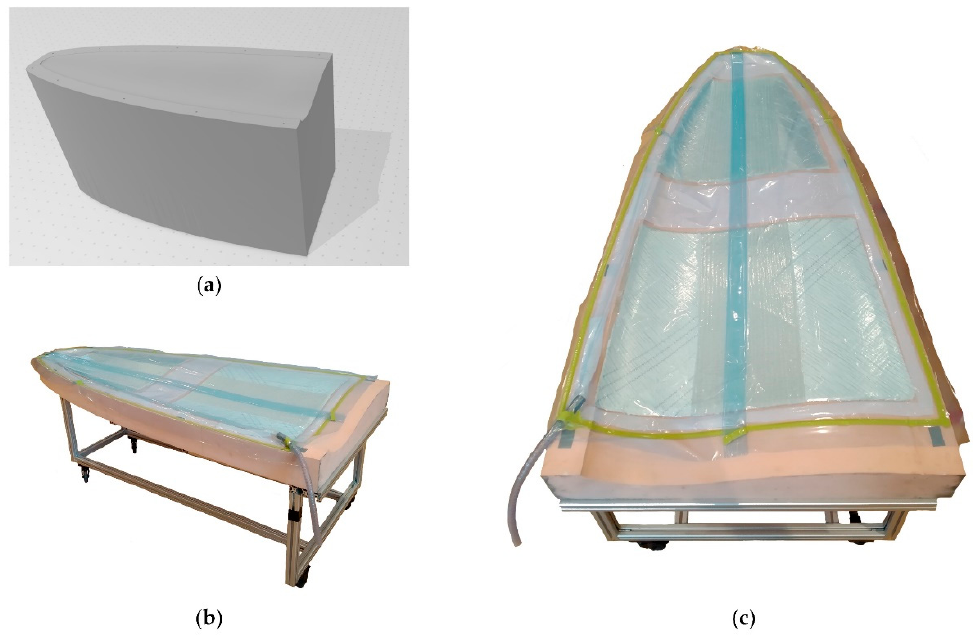
Figure 13. Rotor blade forms. ( a ) 3D model of the tip of the rotor blade form; ( b ) rotor blade form used in the real-world experiment (side view); ( c ) rotor blade form used in the real-world experiment (top view).